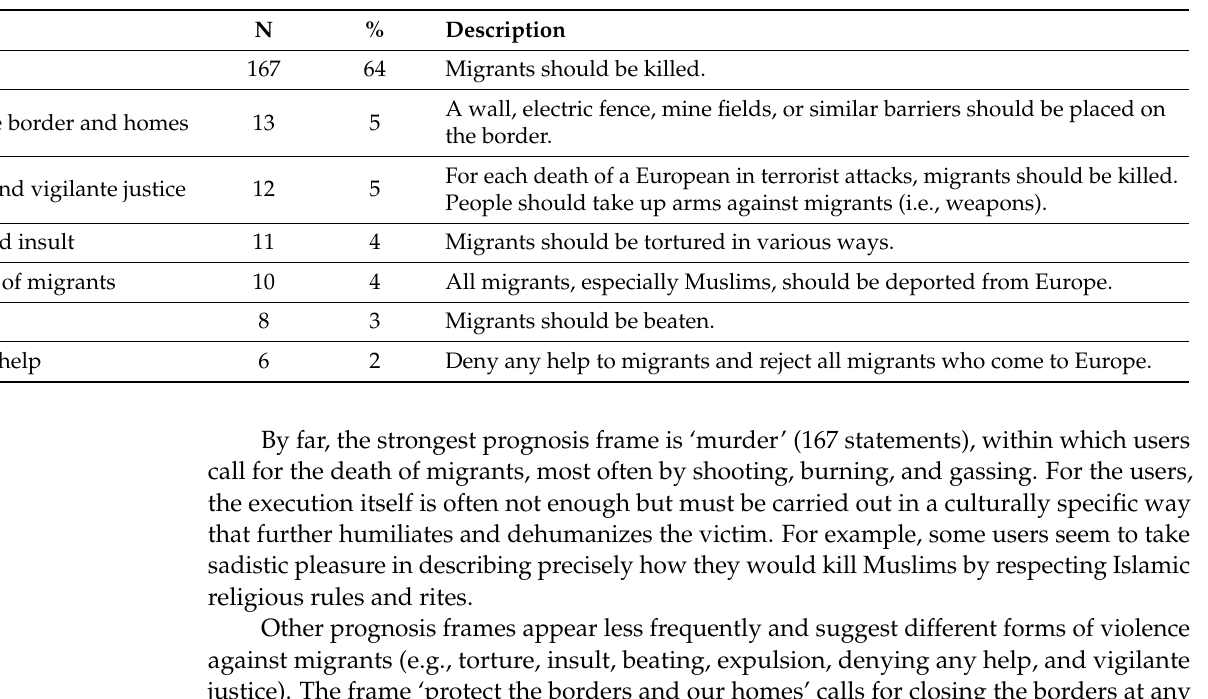
Table 4. Prognosis: frames, numbers, shares, and frame descriptions of the statements (N =